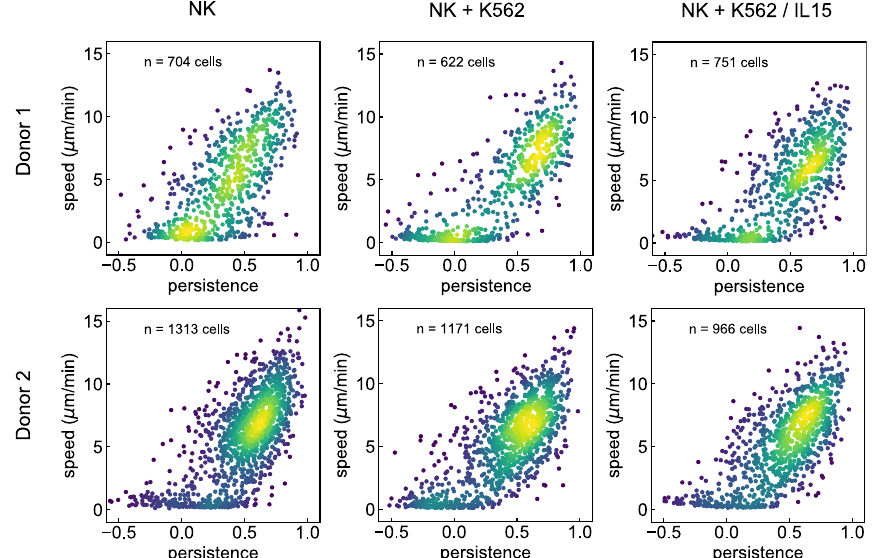
Figure 5. Momentary migration parameters of NK cells in a thick collagen gel. Shown are the joint probability distributions p ( cos (θ) , v ) of persistence (approximated by the cosine of the turning angle) and speed for a system containing only NK cells (left column), for a system of NK cells mixed with wild-type K562 cells (center column), and for a system of NK cells mixed with K562 cells that secret the chemokine IL-15 (right column). Identical experiments have been performed using NK cells from two different donors (rows). The colors represent a kernel density estimation of the continuous probability density. There are no significant differences between the distributions p ( cos (θ) , v ) in the six different